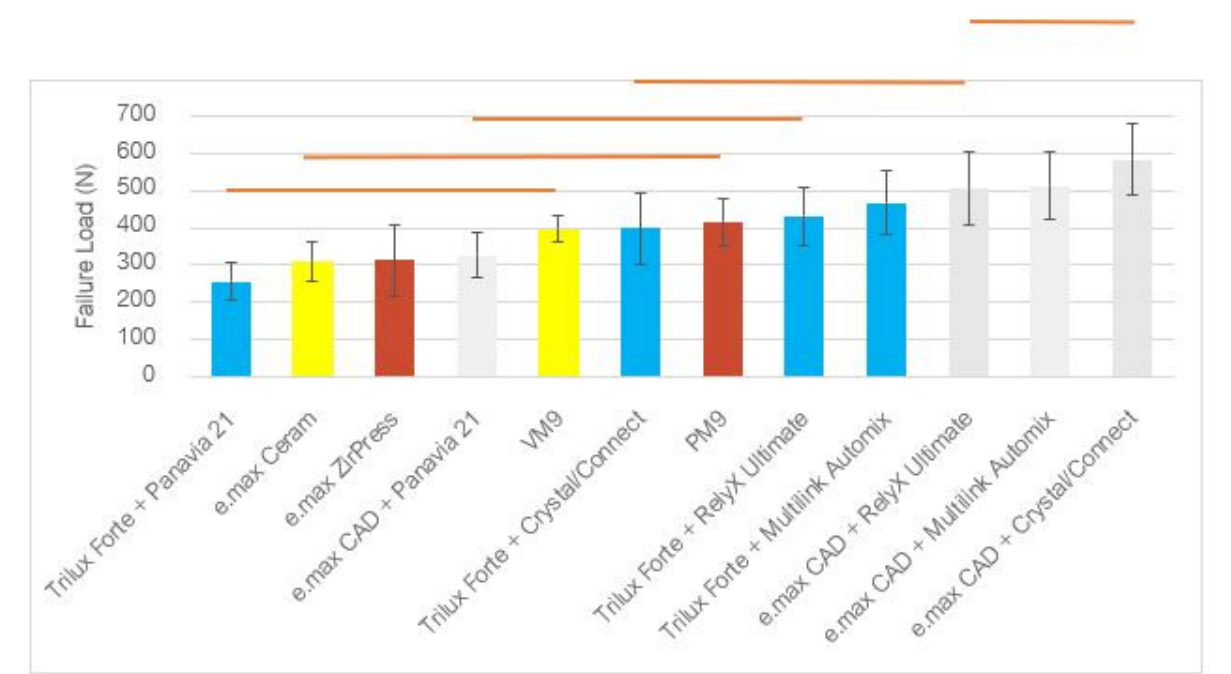
Figure 2. Failure load of bilayered veneer zirconia after 24 h in water. All groups under the same horizontal line are not significantly different to each other ( p < 0.05).